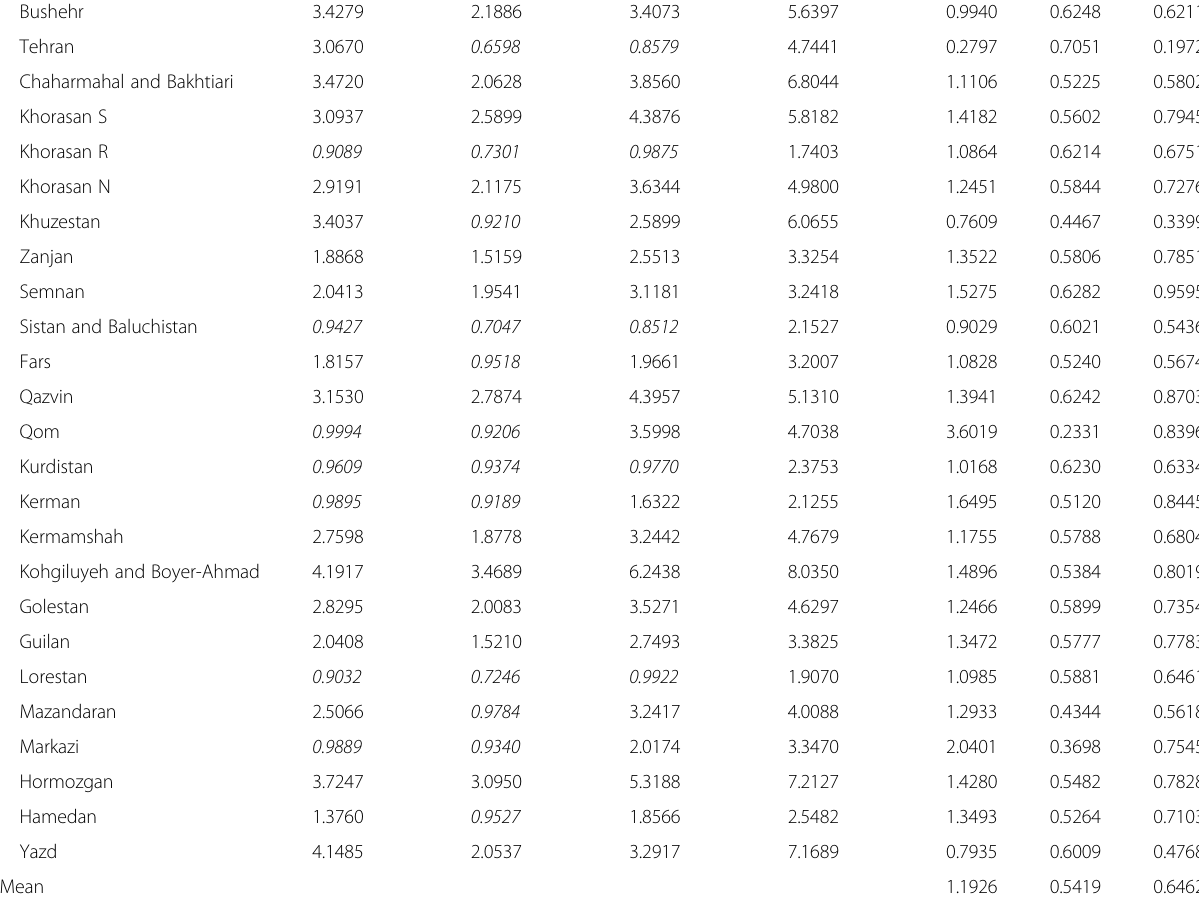
Table 8 OMPI and PMPI values for the 31 Iranian provinces (2015-2016) (Continued)